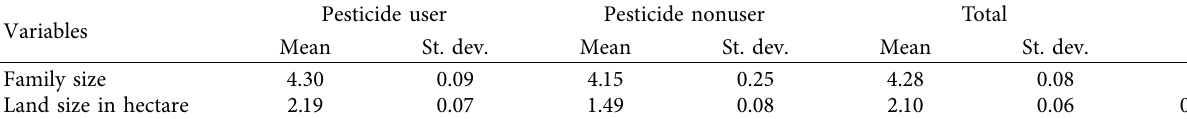
Table 3: Statistical test of continuous variables.